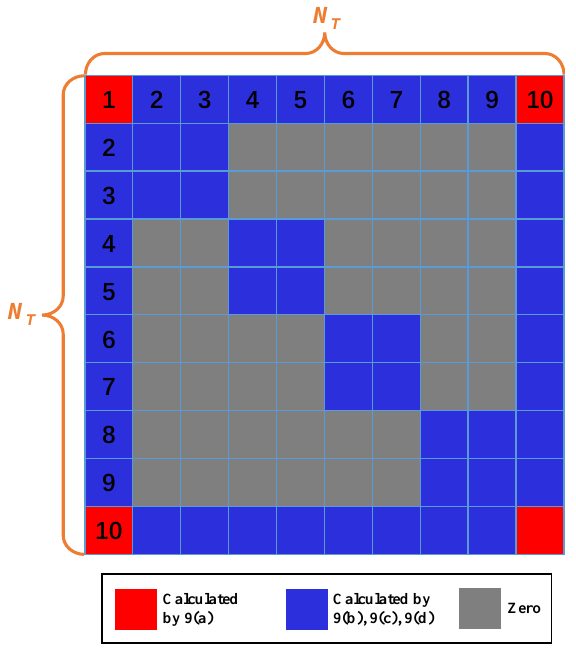
Figure 3. Structure of (cid:98) R